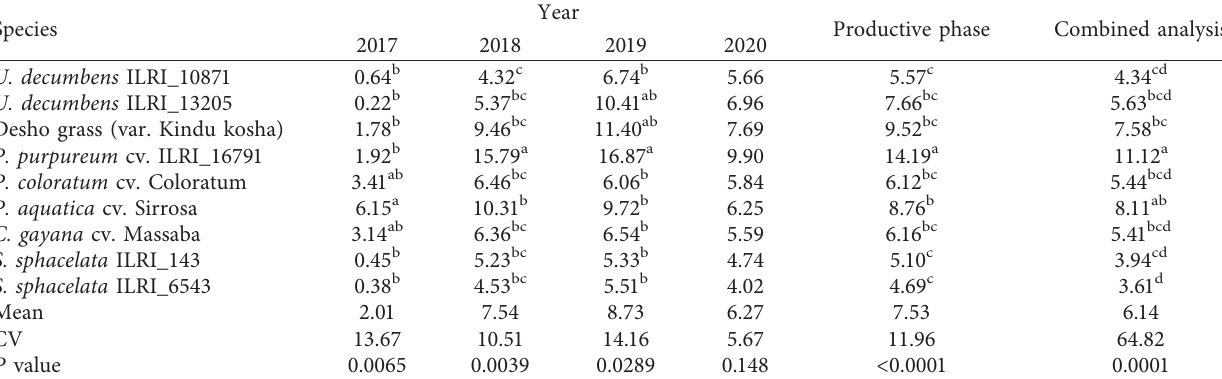
Table 7: In vitro digestible dry matter yield (t/ha) of perennial forage grass species evaluated under irrigation supplementation. Species